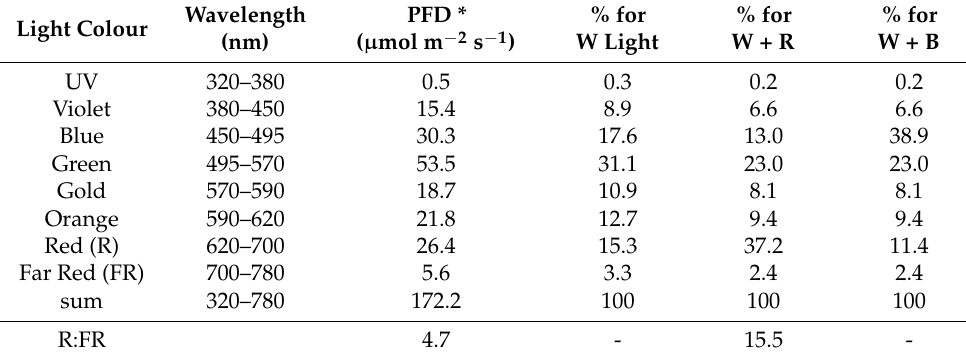
Table 6. Characteristics of white light